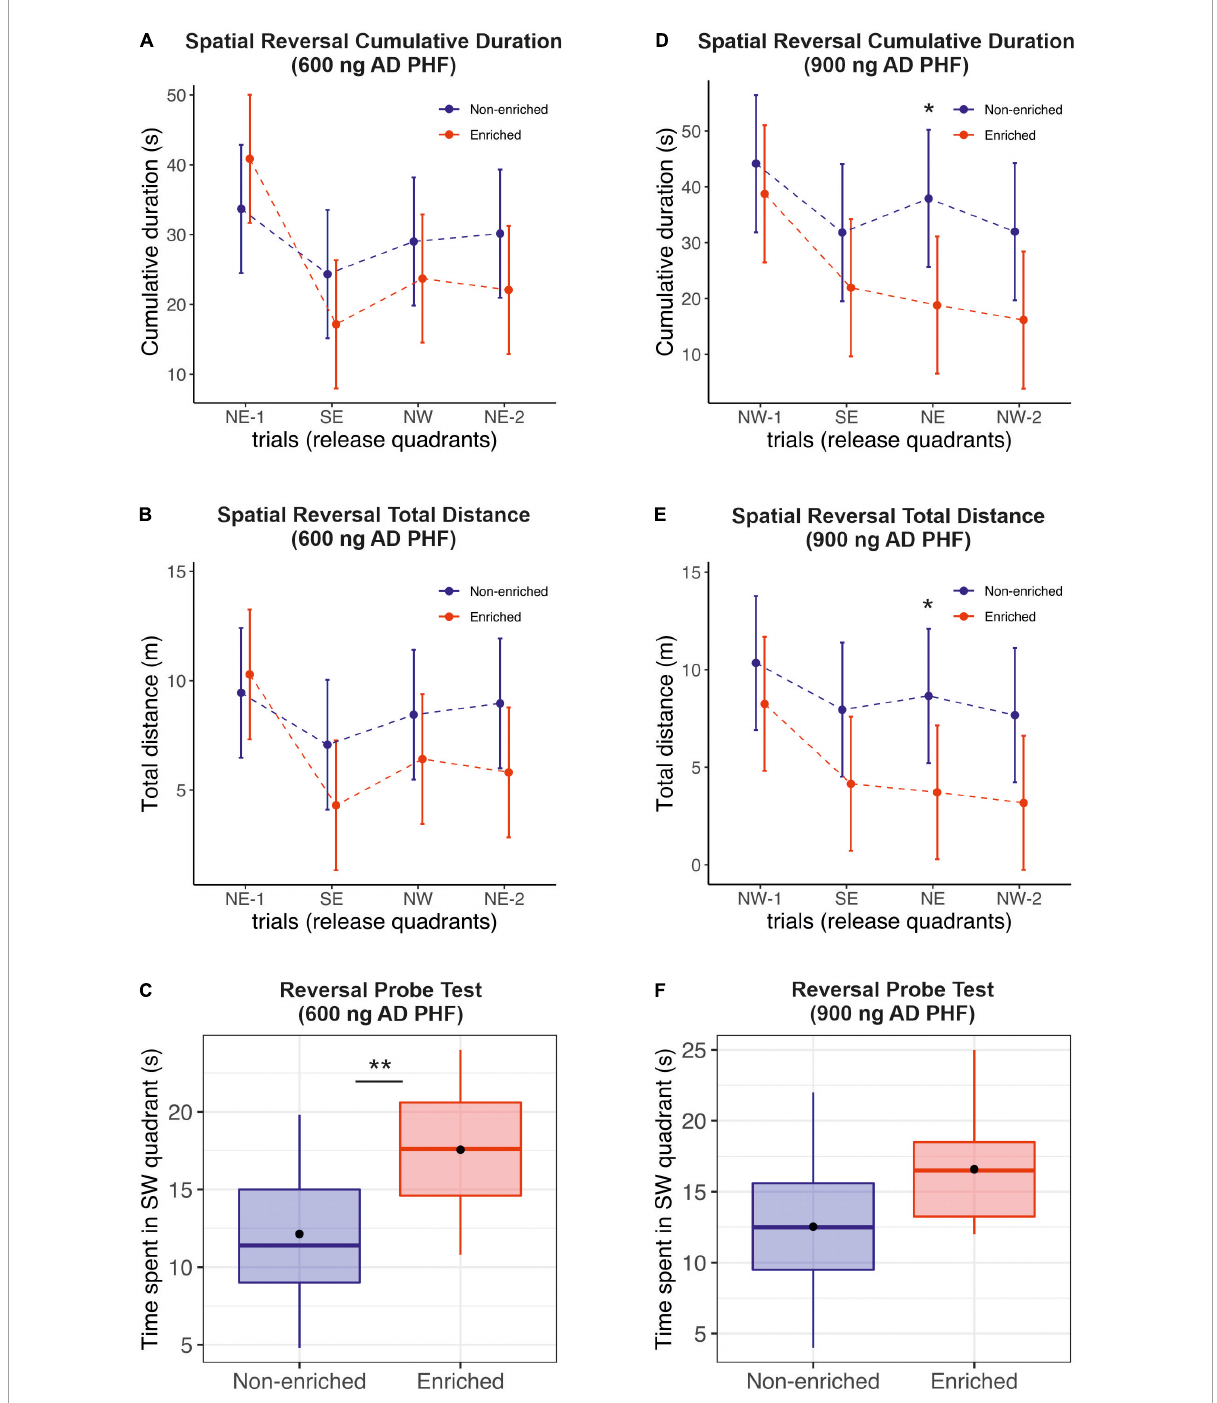
FIGURE3 Evaluation of the effect of enriched environment on reversal learning in transgenic rats injected with different doses of AD PHF. Cumulative duration (A,D) , total distance (B,E) and the time spent in platform quadrant (C,F) during the reversal probe trial were measured, 1st group injected with 600 ng AD PHF (A–C) , 2nd group injected with 900 ng AD PHF (D–F) . Rats exposed to enriched environment generally required slightly less time (A,D) and less total distance (B,E) to find a new platform position (SW) compared to animals in non-enriched group (difference was not significant except at day 3 in the 900 ng group). Animals injected with lowed dose of AD PHF and exposed to enriched environment spent significantly more time in quadrant with new platform position (SW) than their non-enriched counterparts (C) . Animals injected with higher dose (900 ng) of AD PHF displayed a similar trend ( p = 0.07). Graphs (A,B,D,E) represent means and 95% CIs of means for the respective experimental groups. Graphs (C,E) denote median, quartiles, with whiskers showing quartiles ± 1.5 × IQR. Dots denote arithmetic mean. * p < 0.05, ** p <